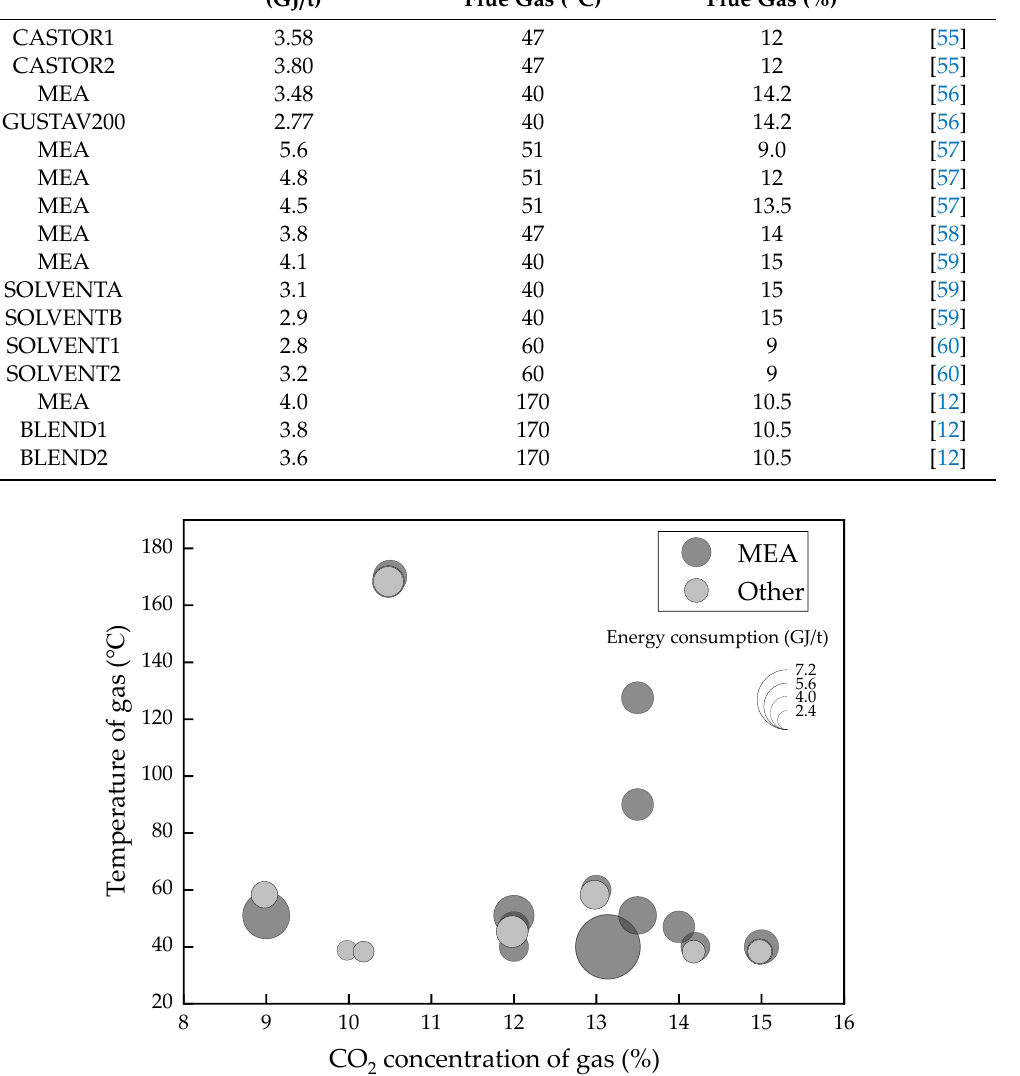
Figure 1. Energy consumption of MEA or blends of large scales CCS Figure1. Energy consumption of MEA or blends of large scales CCS projects. Table 2. Energy consumption data of large scales CCS projects.